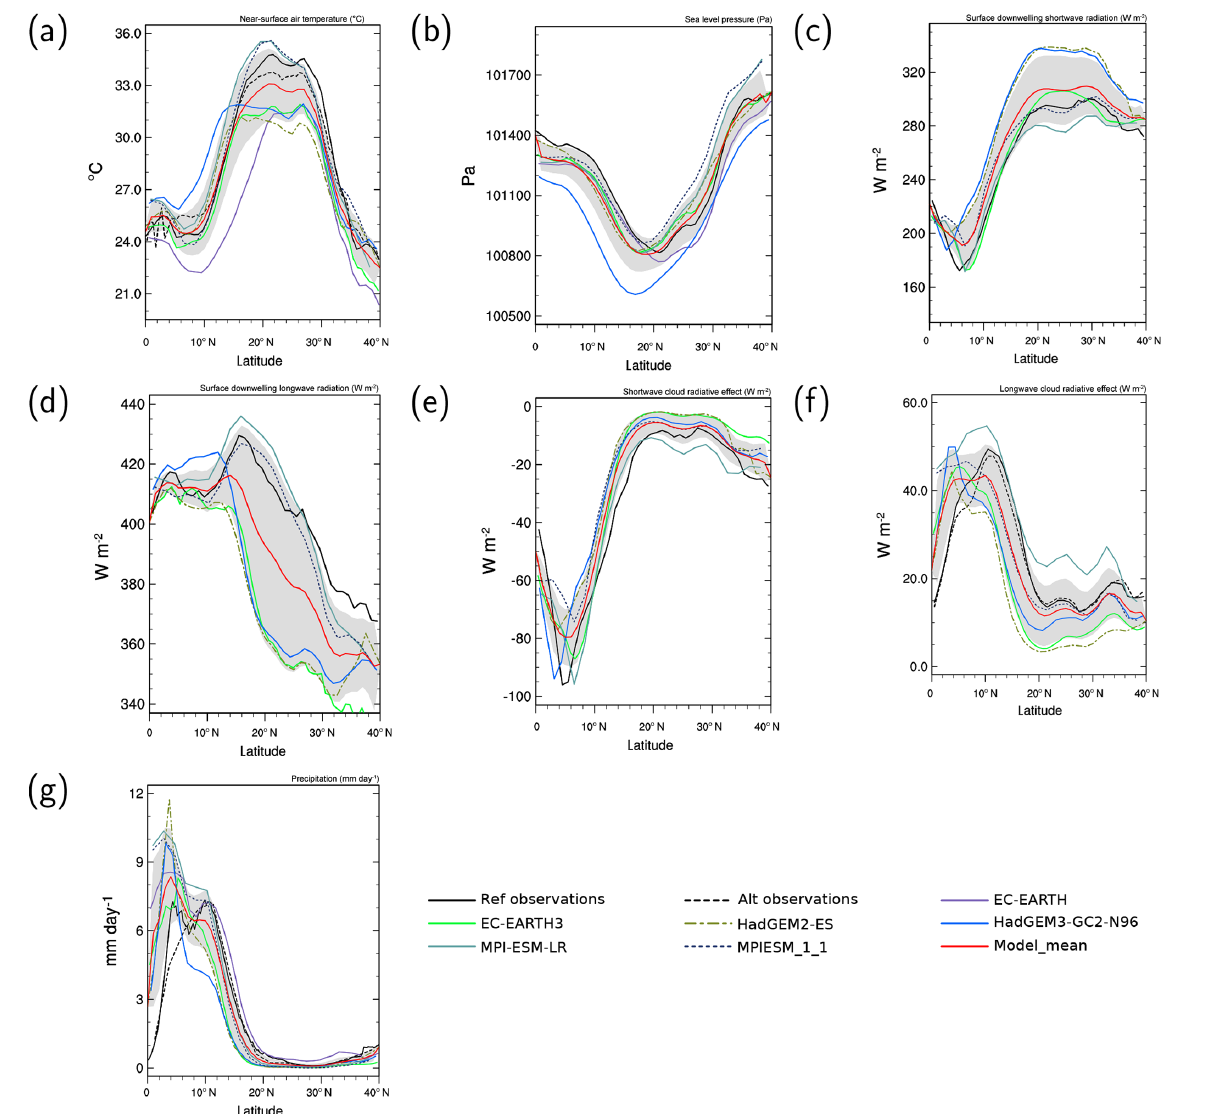
Figure 10. The 10 ◦ W–10 ◦ E zonal average JJAS mean values averaged over the years 1986–2005 (HadGEM: 1986–2004) as a function of latitude ( x axis) for (a) 2m temperature, (b) sea level pressure, (c) surface downwelling solar radiation, (d) surface downwelling longwave radiation, (e) shortwave cloud radiative forcing, (f) longwave cloud radiative forcing, and (g) precipitation. Model results are for the coupled simulations. The reference observations (a, b) ERA-Interim, (c–f) CERES-EBAF, and (g) TRMM-L3 are shown as solid black lines, the alternative observations (a) CRU, (f) SRB, and (g) GPCP-SG as black dashed lines. The gray shading shows the inter-model standard